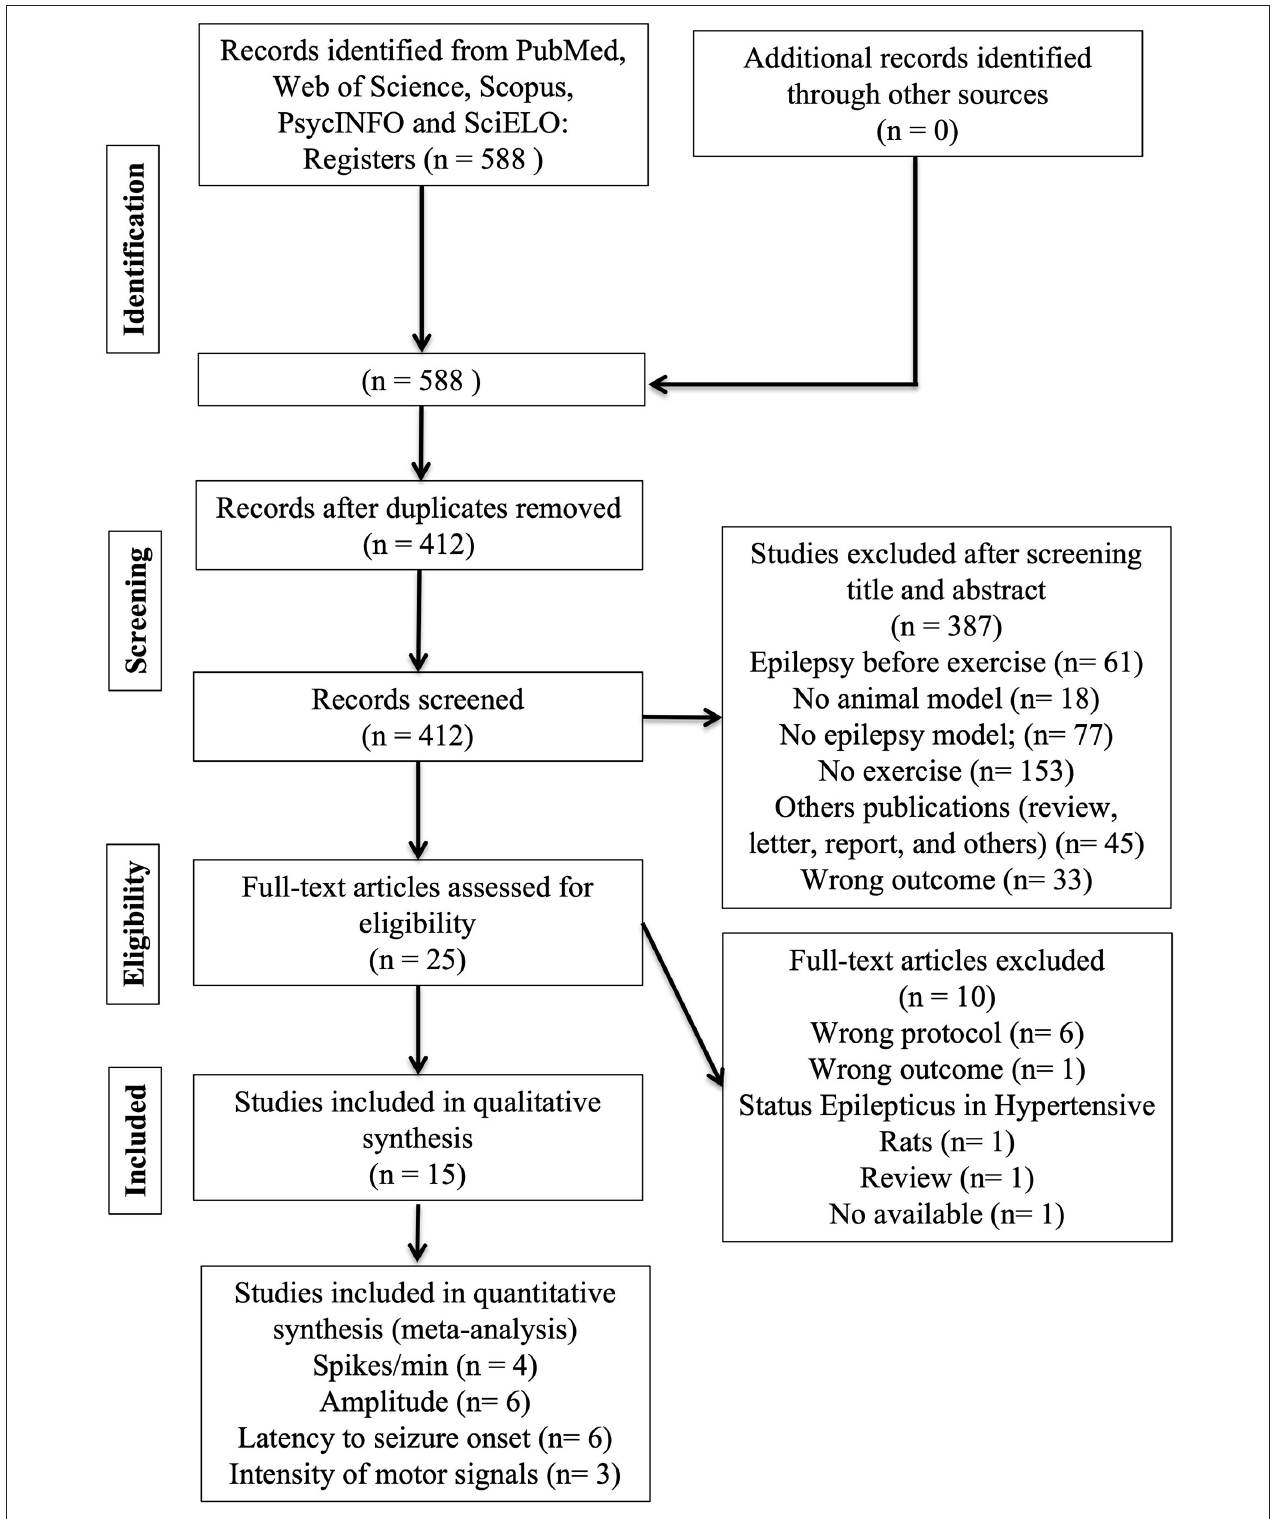
FIGURE 2 | A flow diagram of the systematic review literature search.